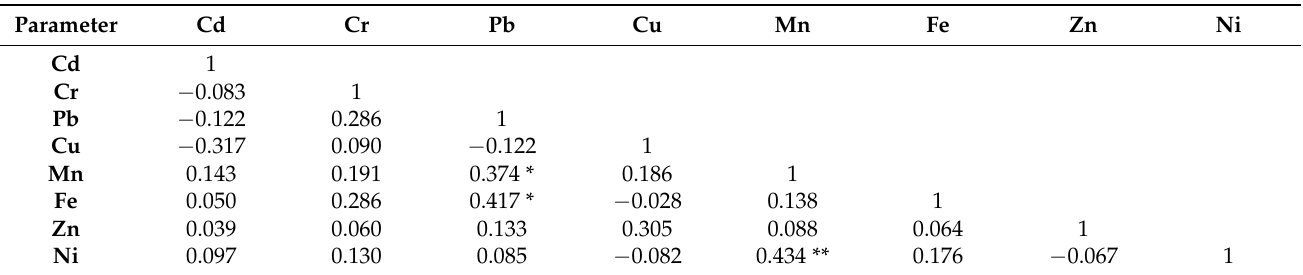
Table 4. Correlation analysis for the concentration levels of heavy metals in groundwater of coastal area of Baluchistan, Pakistan.